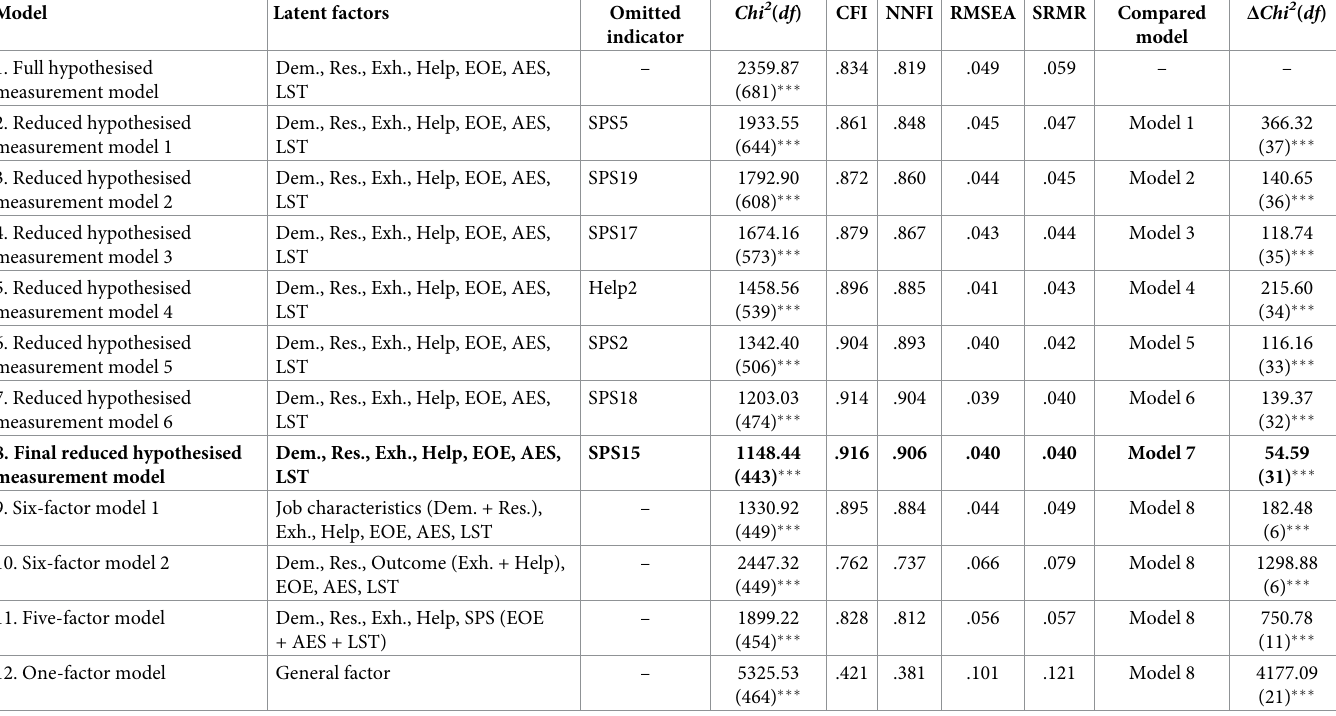
Table 2. Results of the item analysis and confirmatory factor analysis ( N = 1019).